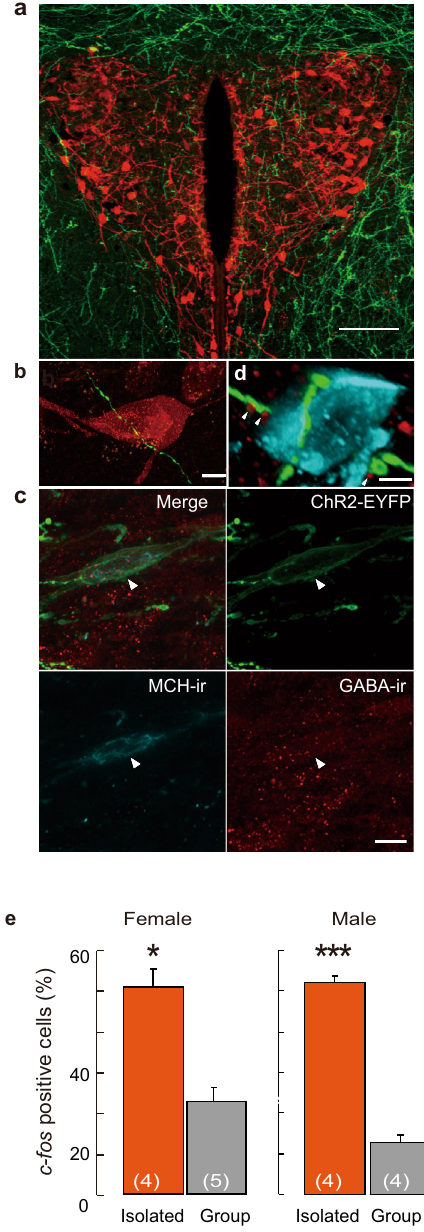
Figure 5. ChR2-EYFP fibres from LHA-MCH neurons project into PVN-oxytocin neurons. ( a ) ChR2-EYFP fibre from MCH neurons into the PVN. ChR2-EYFP fibre surrundings and into the PVN. Scale bar, 100 µm. ( b ) ChR2-EYFP fibre (green) identified in close vicinity of the oxytocin neurons (red). Scale bars, 5 µm. ( c ) Simultanous visualization of GABA-ir and ChR2-EYFP in LHA-MCH neuron (arrowheads). Photopmicrograph revealing ChR2-EYFP (green) expressing MCH-ir (blue) neuron containing GABA (red) in the LHA. Scale, 10 µm. ( d ) GAD65-ir punctate (red) deposits (arrowhesds) in apposition with MCH-ChR2 fiber (green) adjacent to the oxytocin neuron (blue) of the PVN. Scale bar, 5 µm. ( e ) Percentage of c-fos positive oxytcin neurons of isolated or group-housing female and male mice after muscimol (10 ng) injection into the PVN. The animals were perfused 90 min after the injection. Mean ± S.E.M. t-test, * p < 0.05, *** p <